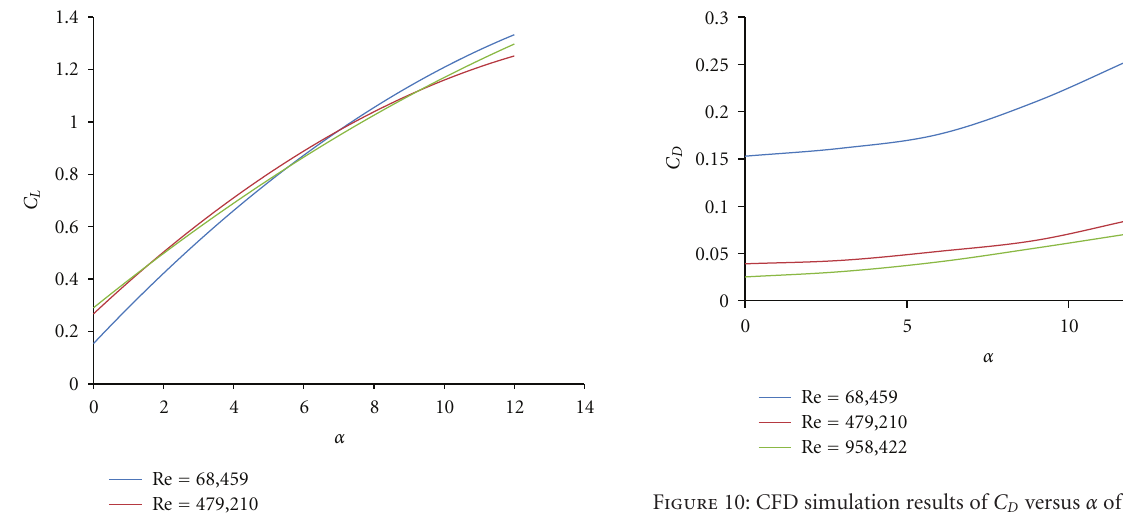
Figure 10: CFD simulation results of C D versus α of NACA 63-421 airfoil.